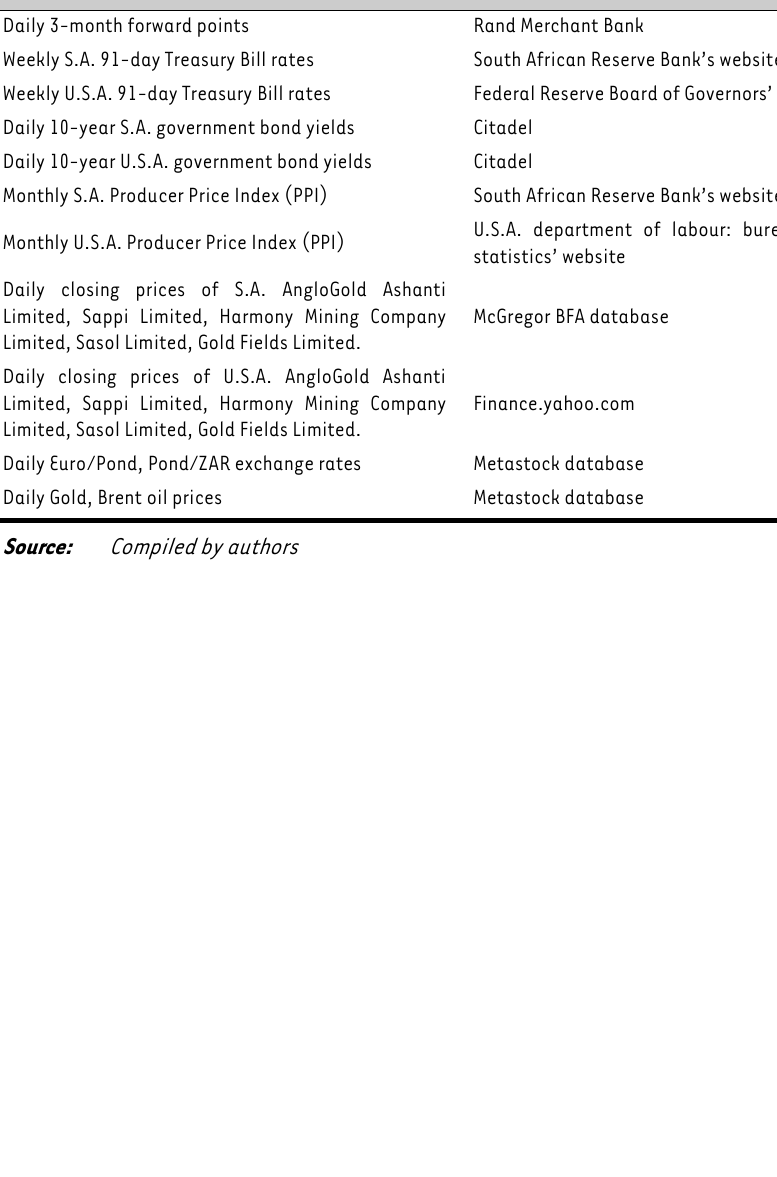
TABLE A1: The data used and its sources